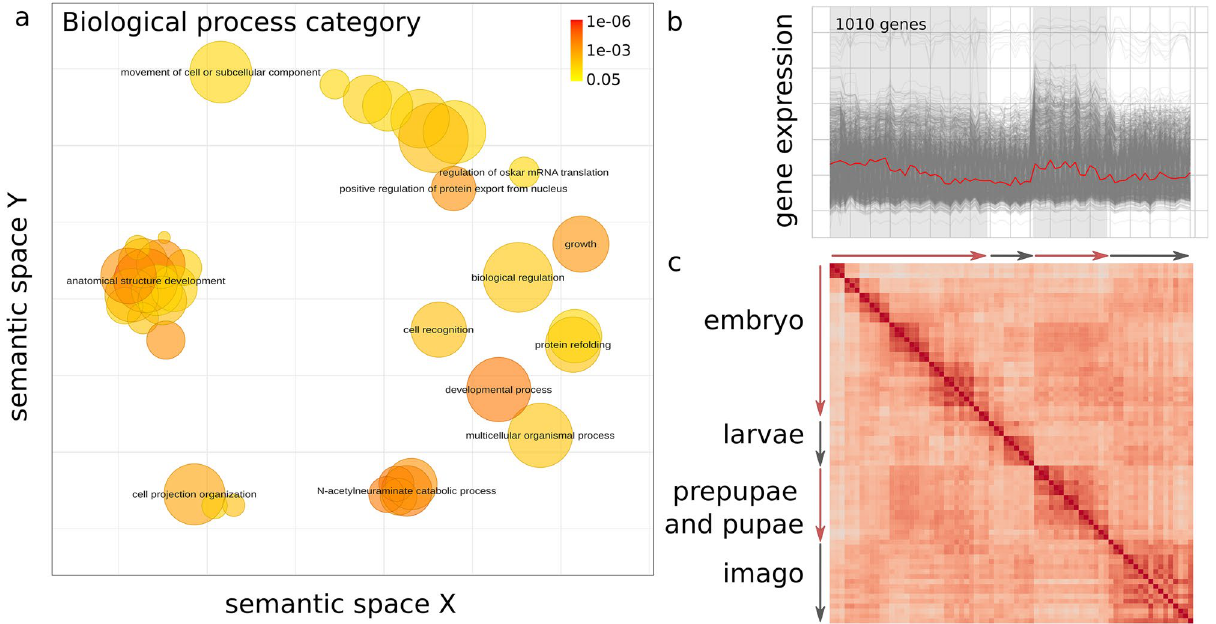
Figure 7. Analysis of the cluster with the zigzag pattern of gene expression in the D. melanogaster dataset. ( a ) GO enrichment results for genes comprising the cluster. GO terms from the Biological Process aspect are projected so that semantically close terms are spatially close. The color represents the adjusted p-value. The size of circles reflects the log-transformed number of the term in the EBI GOA database 30 . ( b ) Gene expression patterns across the development for the selected cluster. ( c ) Pairwise Spearman correlation coefficients for genes from the selected